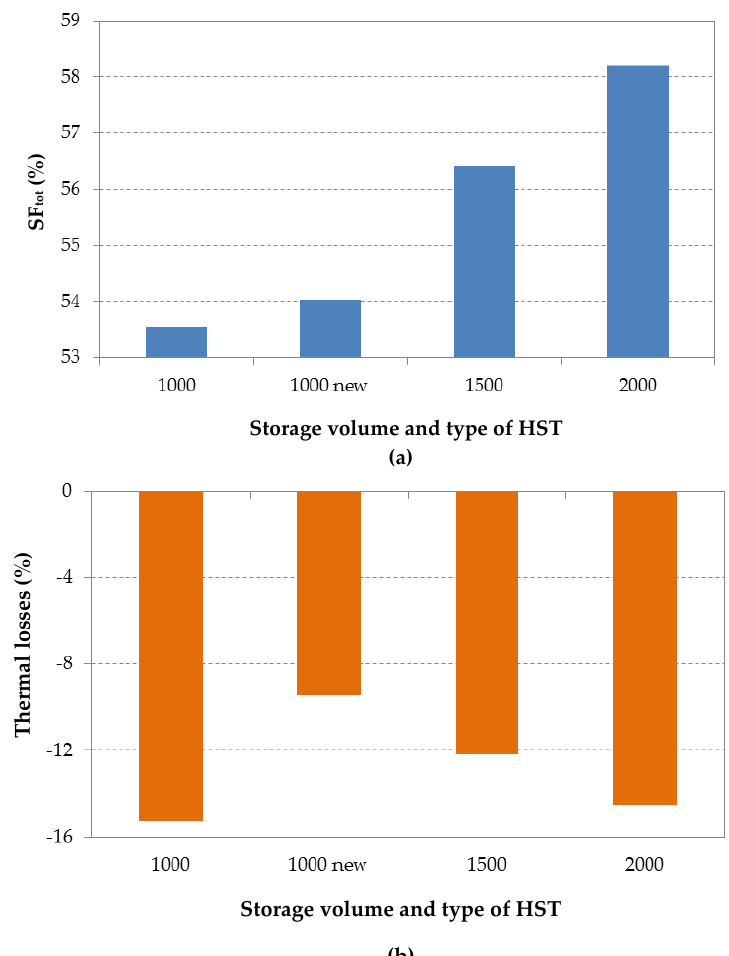
Figure 12. SF ( a ) and thermal losses ( b ) as a function of the storage tank.